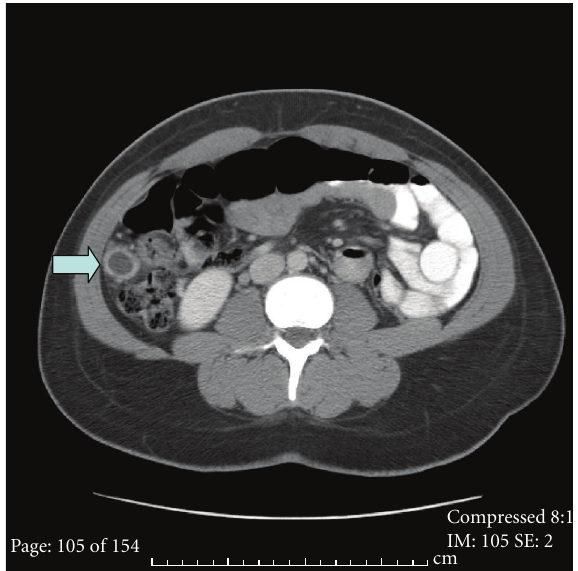
Figure 1: Computed tomography (CT) imaging of the abdomen revealing a 2.2 cm complex cystic structure 2cm inferior to the inferior hepatic border which was suspicious for an ectopic abdominal gestational sac.